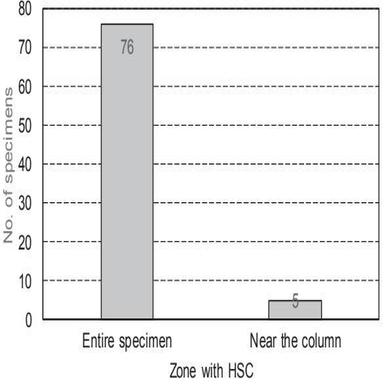
Zone with HSC in monotonic punching tests of non-prestressed flat slab specimens with normal-weight HSC.